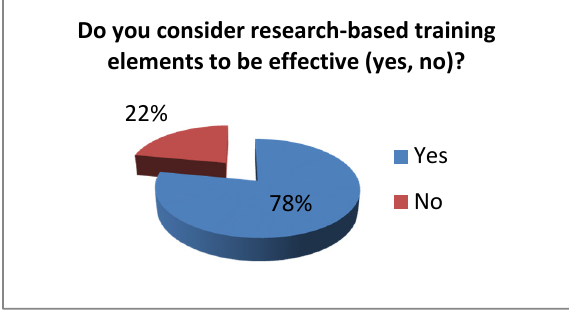
Figure 1. Do you consider research-based training to be effective (yes, no)?